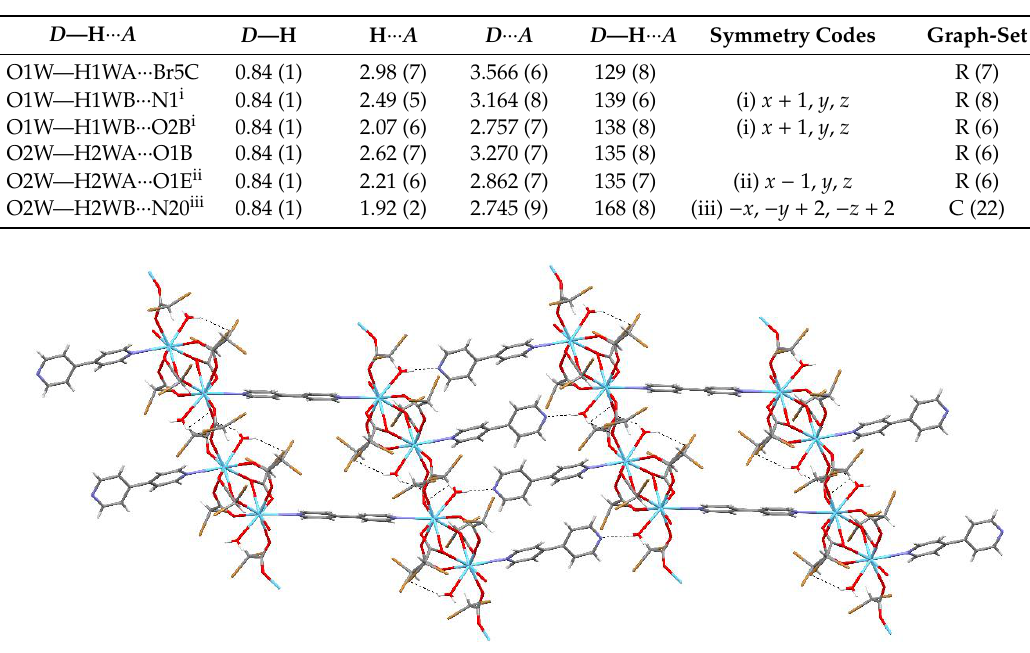
Figure 8. The intermolecular hydrogen bonds for compound 1.